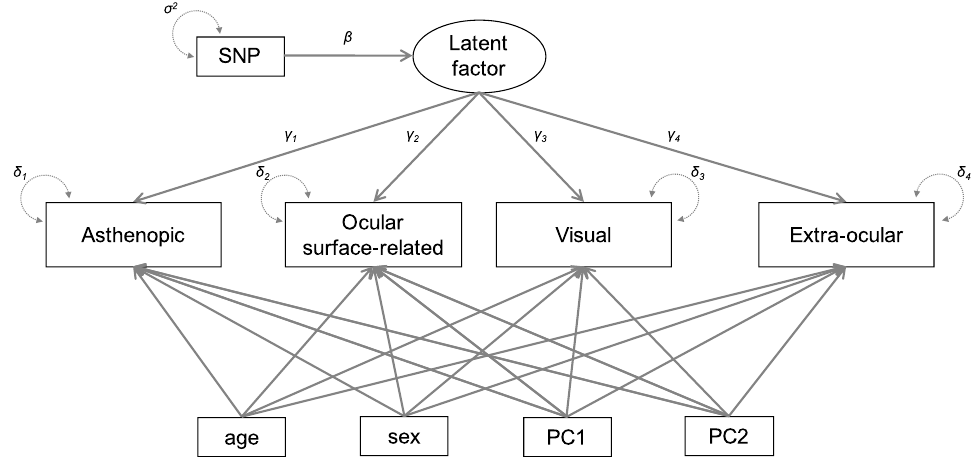
Figure 2. Node diagram of SEM for multi-trait GWAS. The observed variables (four symptom categories) are presented as rectangles and the latent variable as ellipses. Note that each symptom category was calculated by the average of component questionnaires. The association between the latent factor and the observed variables are estimated by the factor loadings (γ k ). GWAS analysis infer the strength of the causal effect (β) from each SNP to the phenotypes via the latent variable. Age and gender, as well as the first two principal components of the PCA performed for population stratification, were added as covariates. The arrows describe the relationships between the variables. Residuals (δ k ) and variances (σ) are drawn as double headed dashed arrows into an